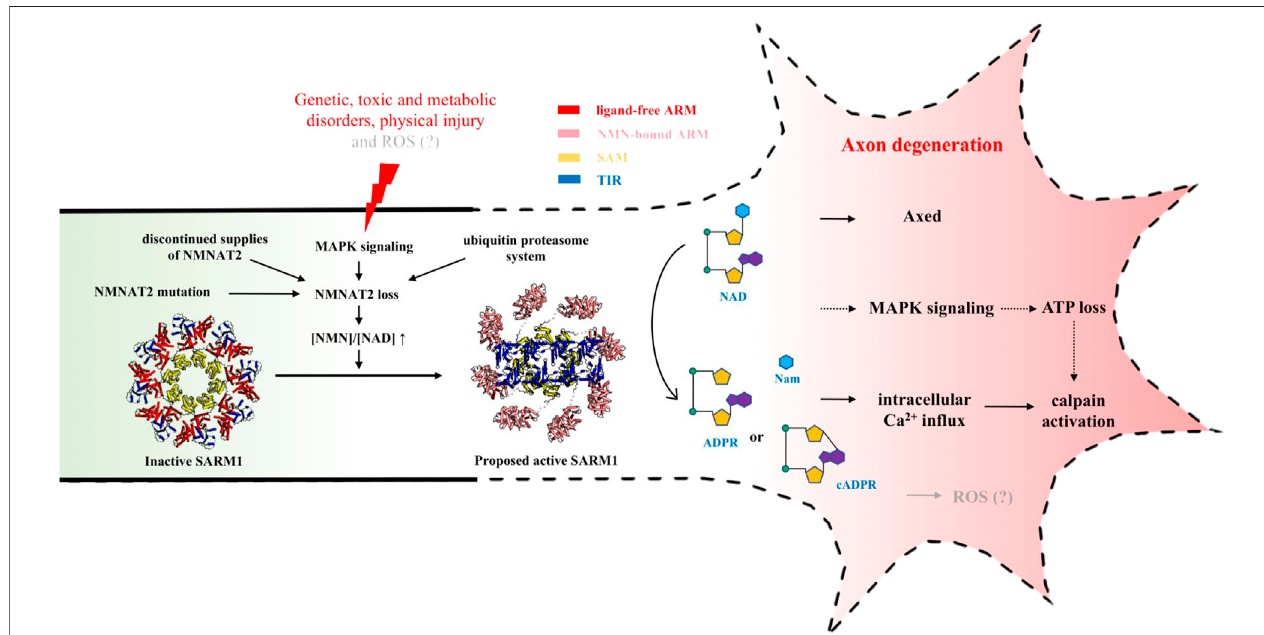
FIGURE3| NAD-mediatedsignalingregulatinginjury-inducedaxondegeneration.Uponinjury,NMNAT2lossresultsinanincreasedratioofNMN-to-NAD,whichis a signal to activate SARM1 from the inactive state (PDB: 7LD0) to active state (PDB (ARM): 7LCZ; PDB (TIR): 6O0R). Active SARM1 cleaves NAD into Nam and either ADPR or cADPR, initiating the pathways downstream, including intracellular Ca 2+ in fl ux, ATP loss, Axed activation and eventually axon